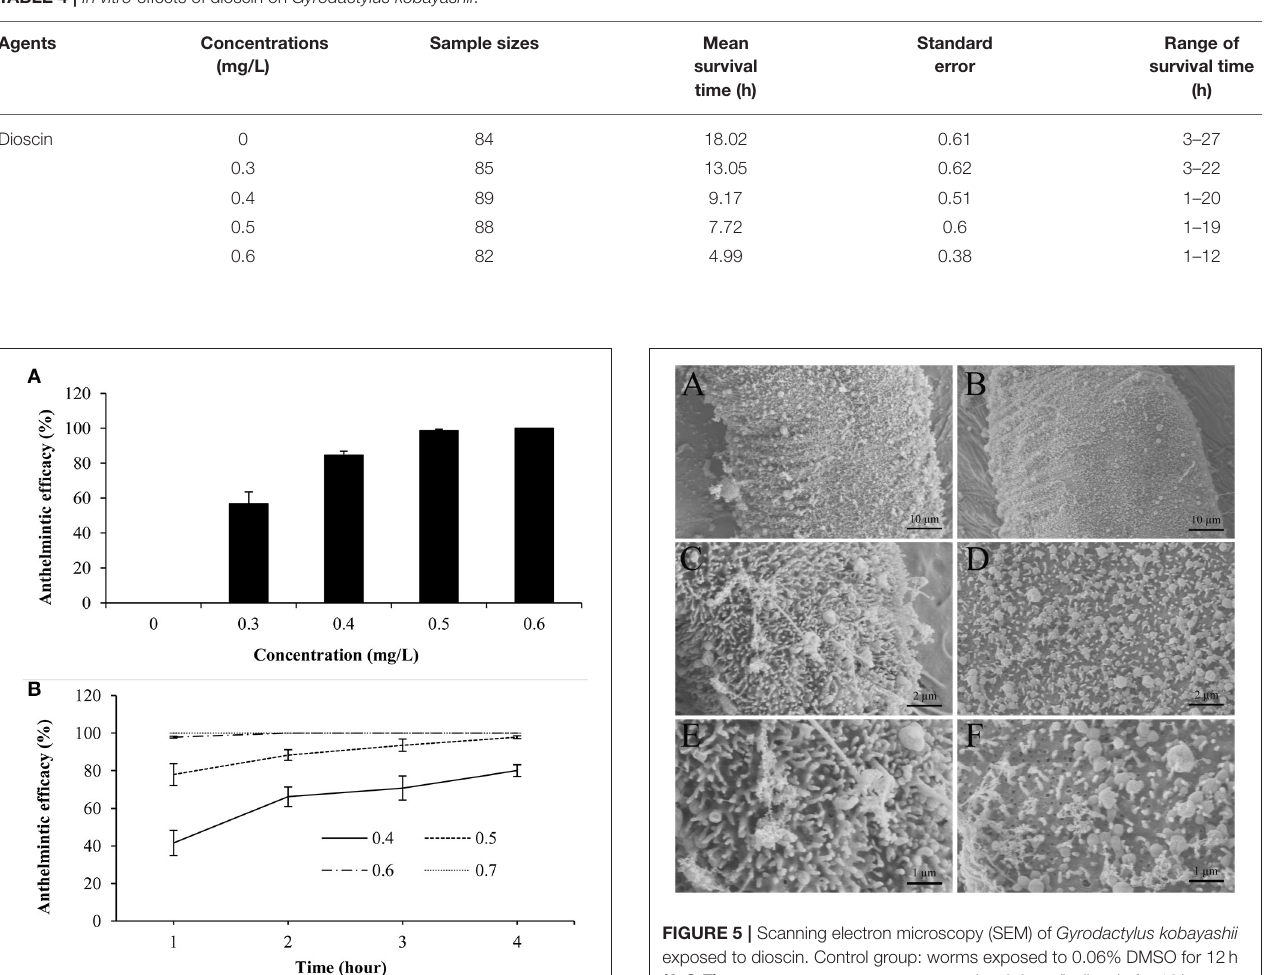
TABLE 4 | In vitro effects of dioscin on Gyrodactylus kobayashii .